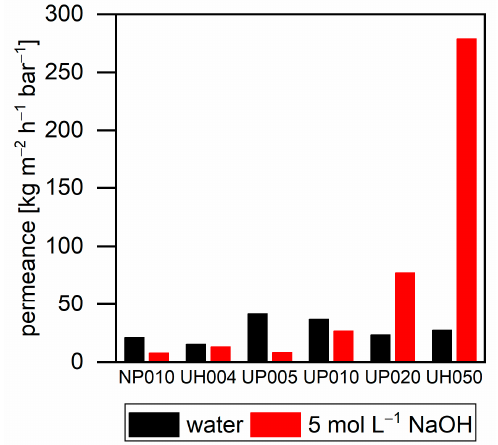
increase in the MWCO of the membranes, the sodium hydroxide flux increased in com-